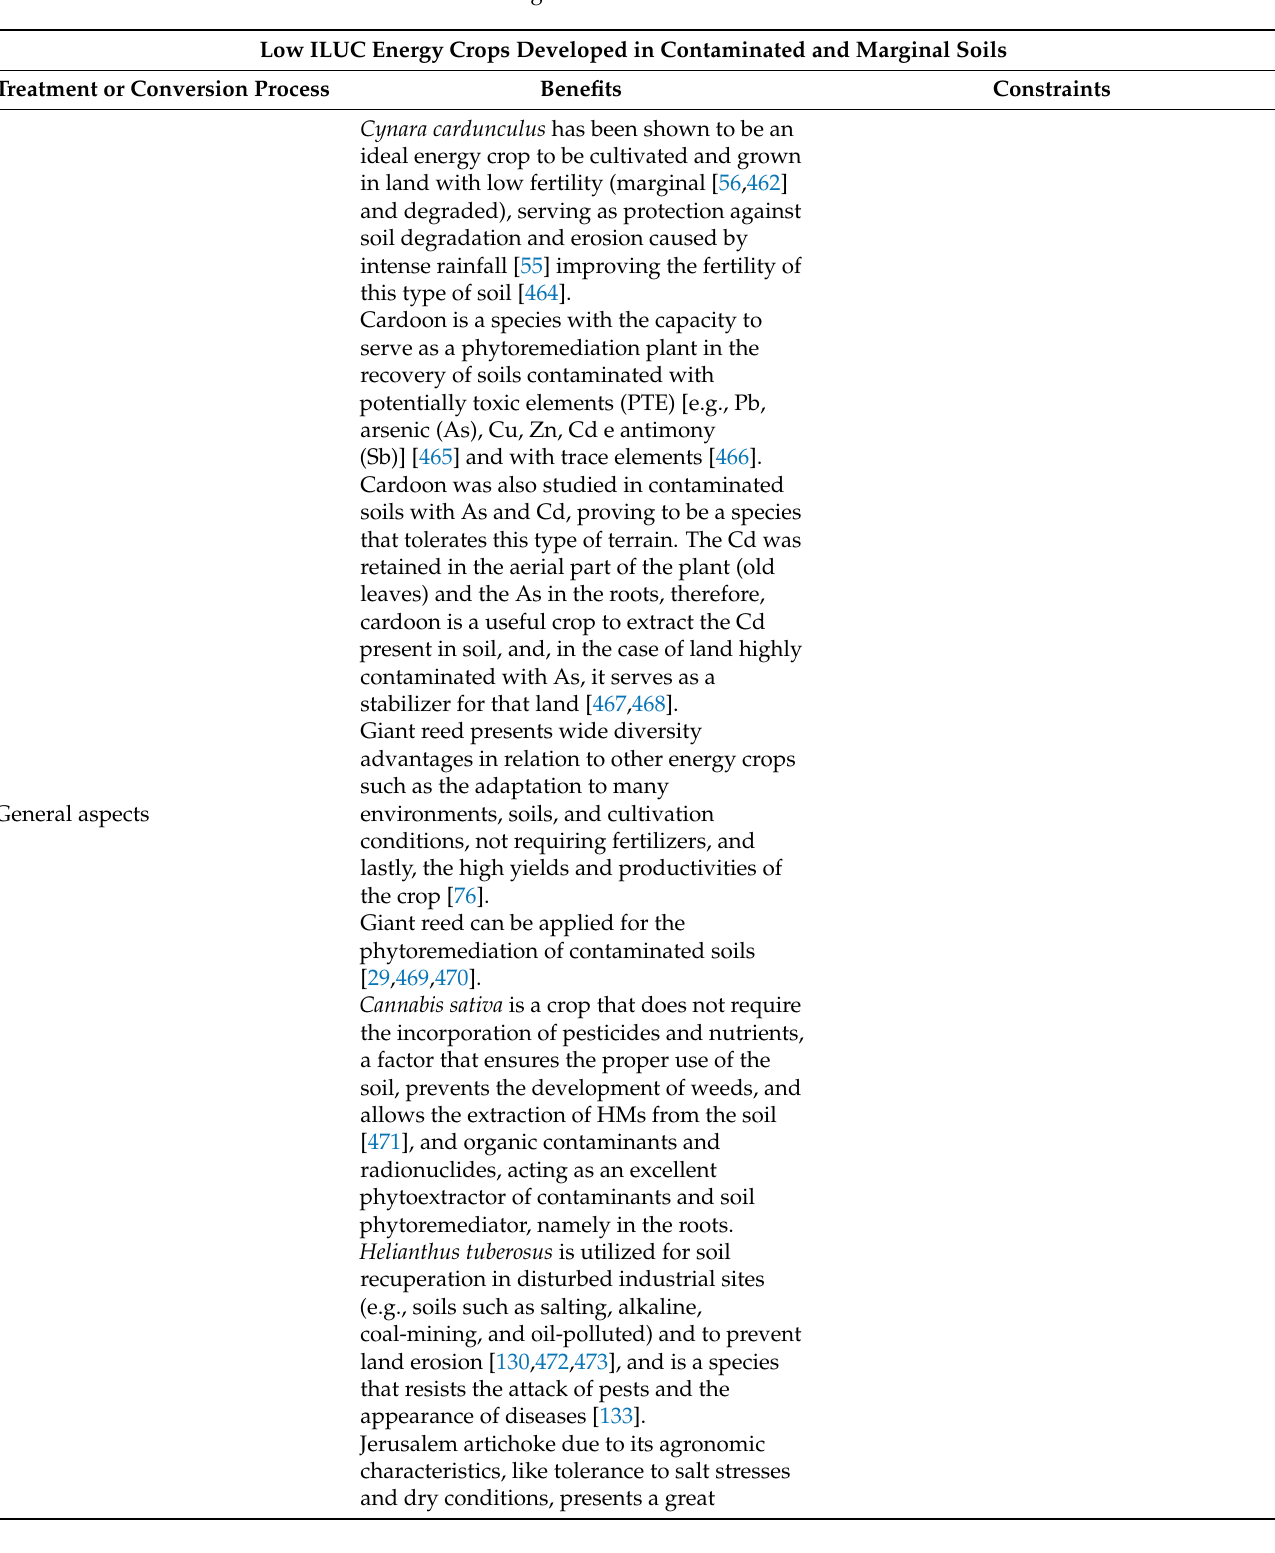
Table 3. Benefits and constraints of bioenergy technologies when energy crops are applied in contaminated and marginal